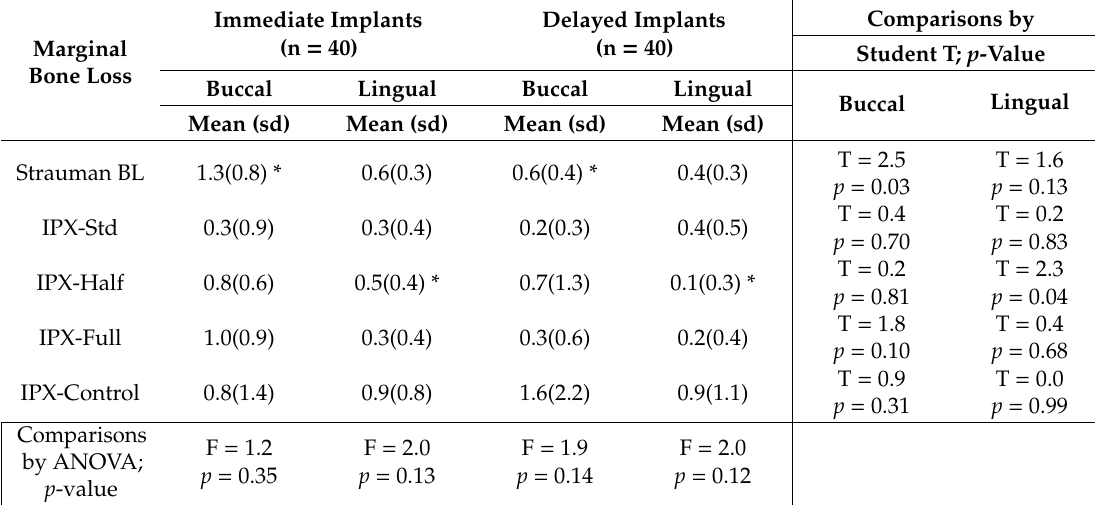
Table 5. Comparison of the marginal bone loss (the distance between IS and B) between delayed and immediate implants in both the buccal and lingual sides (mm) among the implant subgroups. * Statistically significant inter-group comparisons according to ANOVA test ( p <